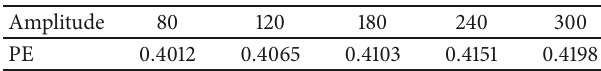
Table 3: The permutation entropy values corresponding to different frequency of modulation signal.